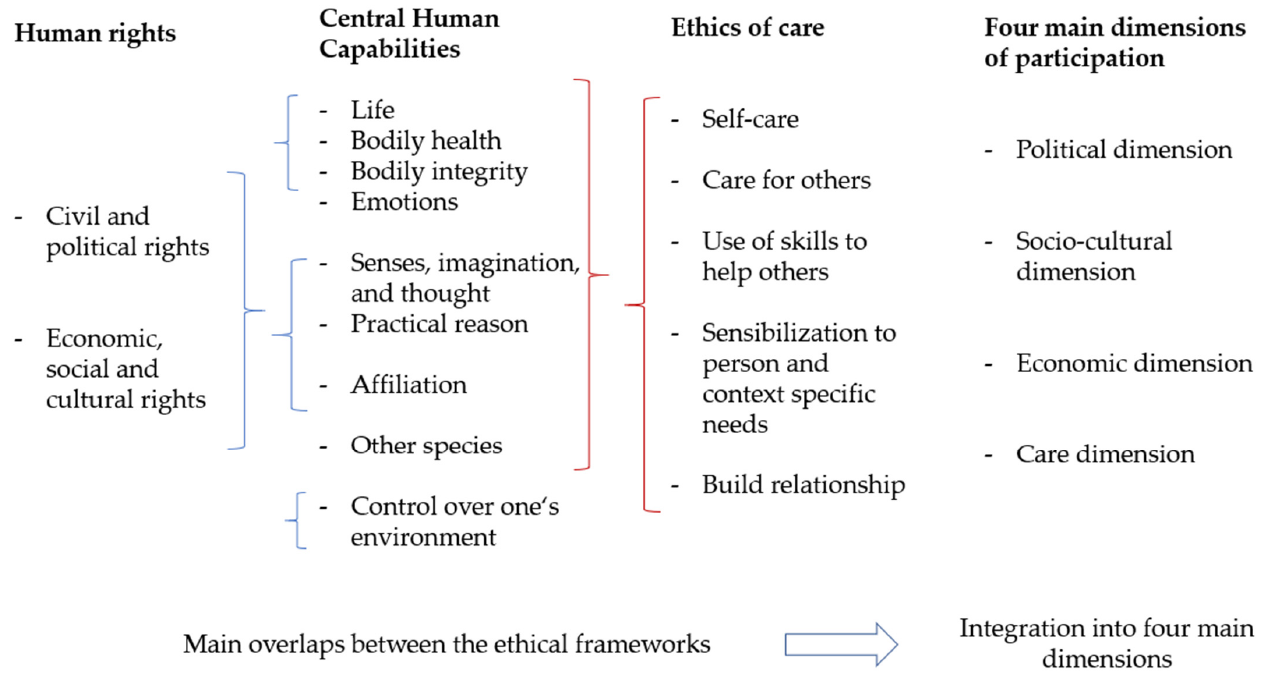
Figure 2. Development of the ethical framework.